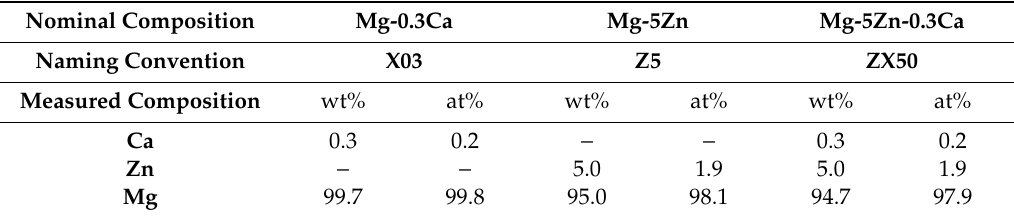
Table 1. The chemical compositions of the alloys in wt% and at%, as measured by X-ray Fluorescence Spectroscopy (XFS) before immersion into simulated body fluid (SBF).